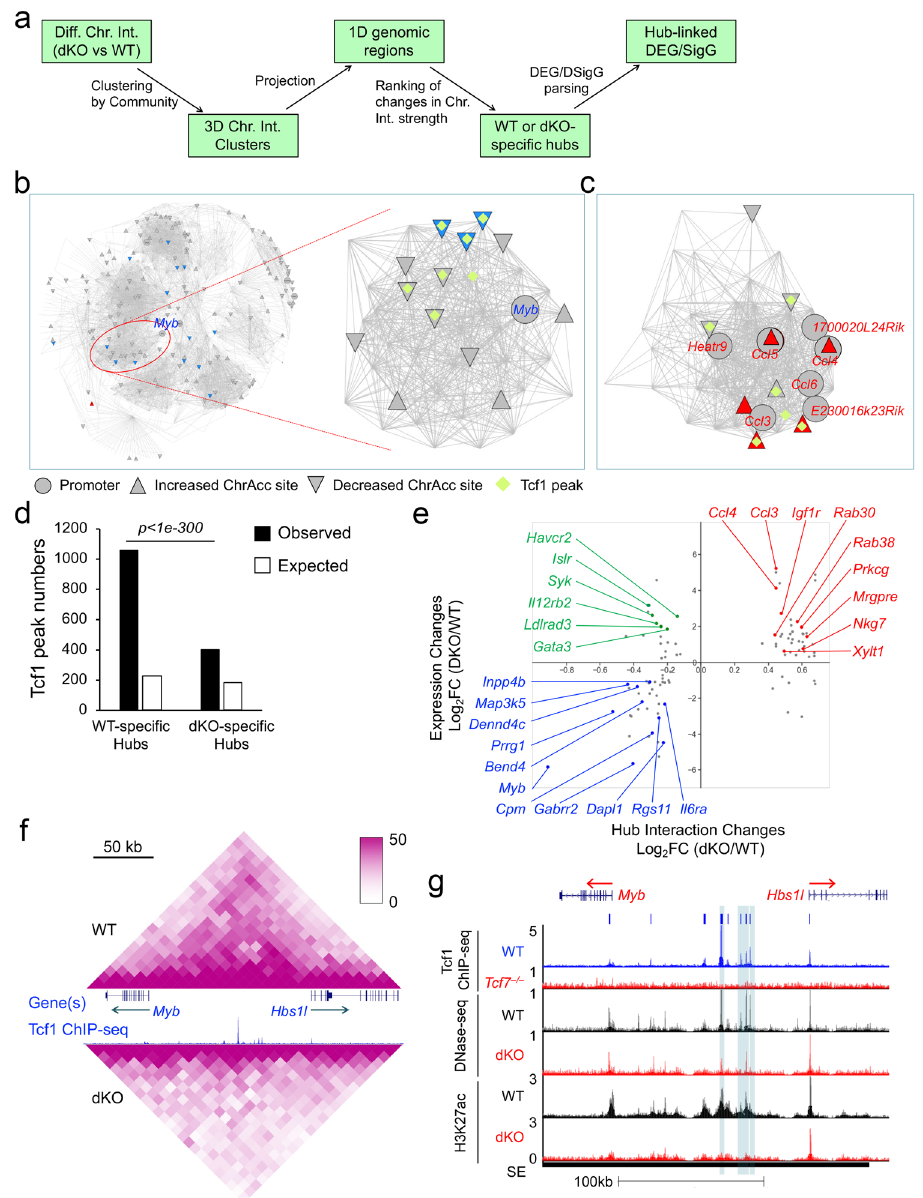
Fig. 7 Tcf1/Lef1 TFs promote formation of chromatin interaction hubs for target gene transactivation. a A diagram showing work fl ow of identifying WT- and dKO-speci fi c chromatin interaction (Chr. Int.) hubs and hub-associated target genes. b Visualization of the output from chromatin interaction hub analysis. Shown on the left is the network containing decreased chromatin interactions connected to the Myb promoter (up to depth three nearest neighbors), where the nodes represent 10-kb bins on chromosome 10 and the lines represent chromatin interactions decreased in dKO CD8 + T cells. On the right is the WT-speci fi c hub harboring the Myb gene. c A cluster on chromosome 11 harboring Ccl gene loci formed a dKO-speci fi c hub. In ( b ) and ( c ), gene symbols are marked at the promoters (circle), with blue and red font denoting down- and upregulated expression in dKO CD8 + T cells, respectively. Triangles fi lled with blue and red denote statistically signi fi cant decrease and increase in ChrAcc in dKO CD8 + T cells, respectively. d Tcf1 peaks are more enriched in WT-speci fi c hubs compared with dKO-speci fi c hubs. The expected numbers of Tcf1 peaks were estimated based on genome average, and statistical signi fi cance is calculated using the one-sided Poisson test. e Scatterplot showing correlation between the changes of interaction strength in differential chromatin interaction hubs and expression changes of their associated genes, with selected genes marked. The x -axis value of a dot represents the median of all interaction changes in the corresponding hub. f Two-dimensional display of changes in chromatin interaction within the Myb -containing hub in WT and dKO CD8 + T cells. g One-dimensional display of changes in ChrAcc and H3K27ac within the Myb -containing hub in WT and dKO CD8 + T cells. Blue vertical bars denote ChrAcc sites showing reduction in dKO Lef1-mediated chromatin interactions could exert repressive such sites can be found in the Syk intron, Fig. 5d), where the function on transcription. In line with this notion, Havcr2 , ChrAcc sites may function as transcriptional repressors. As a Il12rb2 , Ldlrad3, and Syk genes were linked with Diff ChrAcc highlight of this point, the Ldlrad3 (a pDC or monocyte LEG) Cluster 2 (i.e., decreased ChrAcc sites coupled with increased gene locus was in a WT-speci fi c hub formed on a chromosome gene expression in dKO CD8 + T cells, Fig. 5a; one example of 2 segment (Fig. 8a), and its gene body and downstream region